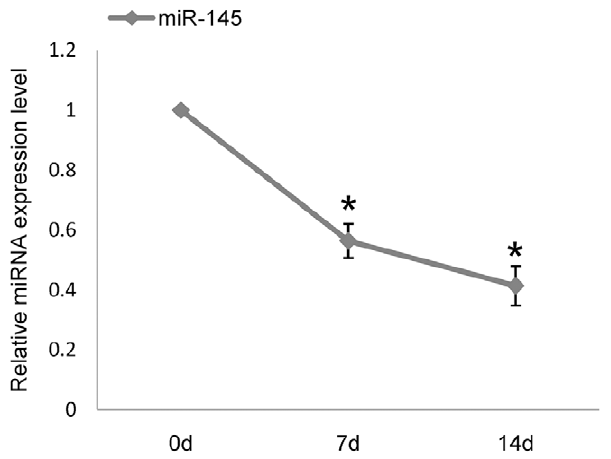
Figure 1. Differential expression of miR-145 during chondro- genic differentiation of murine MSCs. Down-regulated expression of miR-145 in murine MSCs induced by TGF- b 3 was identified by qRT- PCR at different stage of chondrogenic differentiation (0 d, 7 d, 14 d). The relative expression level of miR-145 in untreated MSCs (0 d) was set to one, as control. Three independent cell culture experiments were done and data was represented as mean 6 sd. *, p , 0.05, when compared with